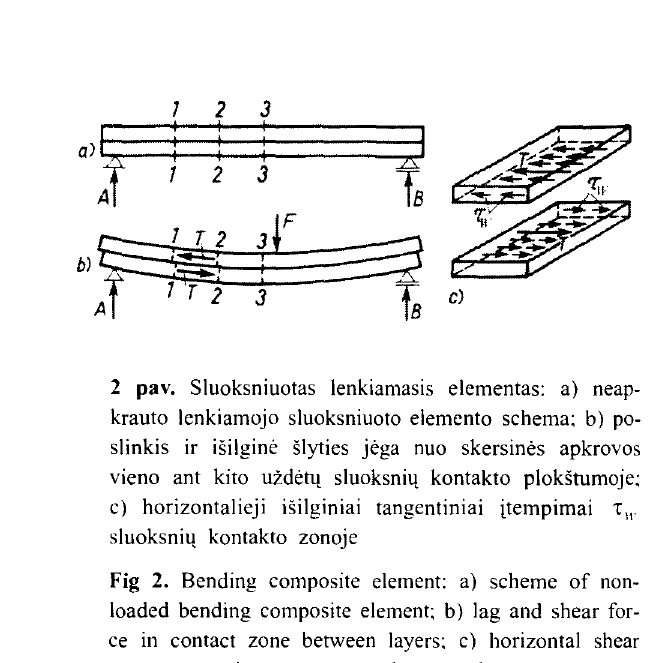
krauto lenkiamojo sluoksniuoto elemcnto schema: b) po slinkis ir isilgine slyties jega nuo skersines apkrovos vieno ant kito uzdetll sluoksniq kontakto plokstumoje: c) horizontalieji isilginiai tangentiniai itempimai '" sluoksniq kontakto zonoje Fig 2. Bending composite element: a) scheme of non loaded bending composite element: b) lag and shear for ce in contact zone between layers: c) horizontal shear stresses 't\1' in contact zone between layers Remiantis Jiteratiiros saltiniais [2-4]. sudetinis